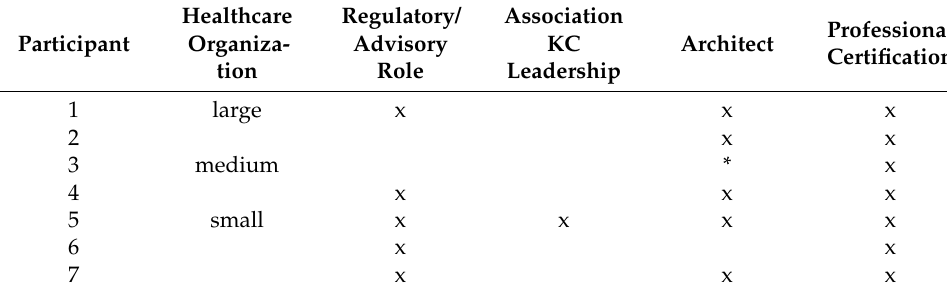
Table 1. National Design Advisory Council affiliations. Participant